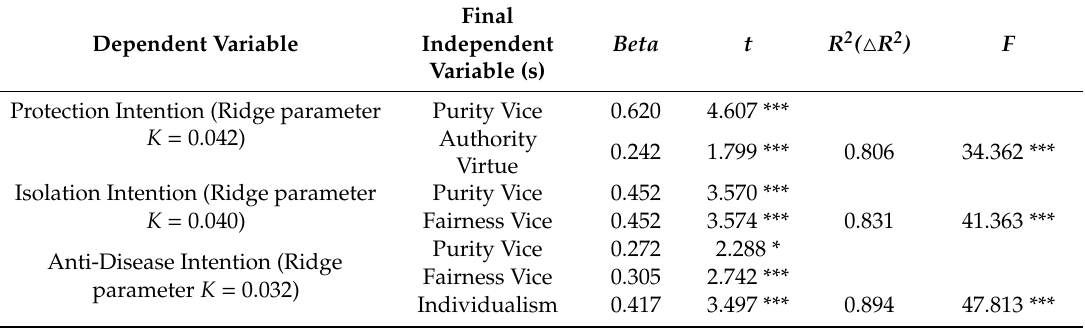
Table 11. Details of multiple regression—moral concern / cultural values and behavioral intentions.